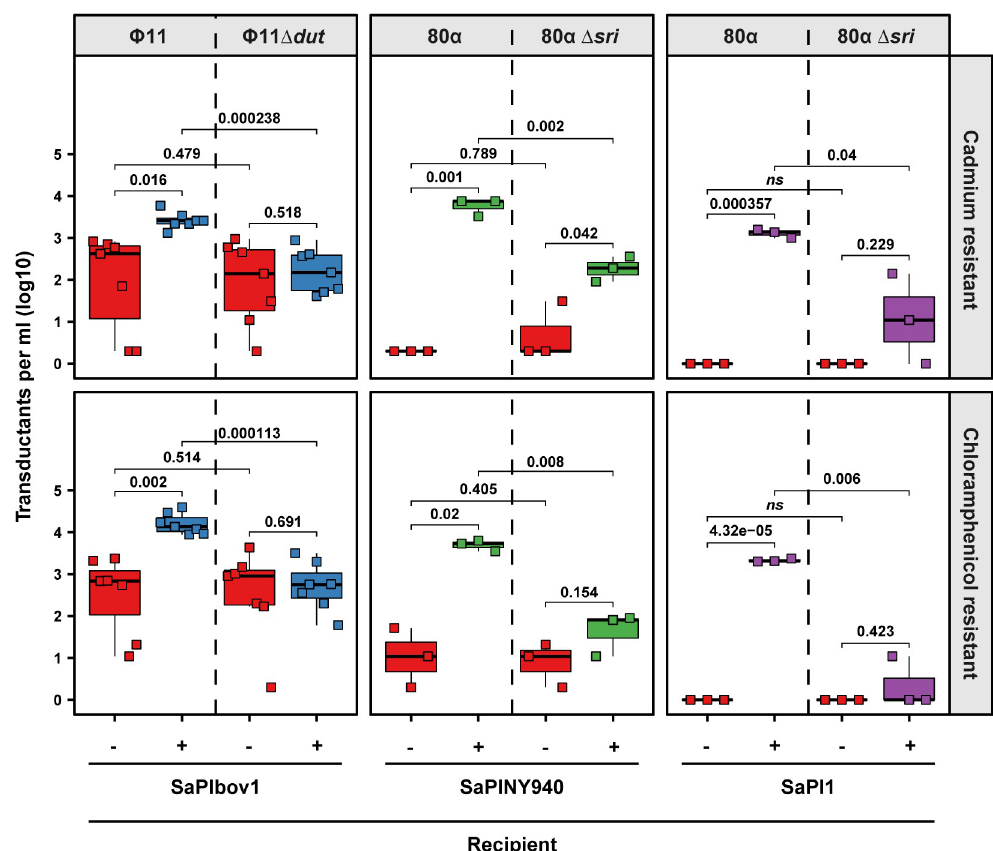
Fig 1. SaPIs promote the survival of transductants. S . aureus RN4220 derivative strains either devoid of (red) or harboring either SaPIbov1 (blue), SaPINY940 (green) or SaPI1 (purple) were infected with an MOI of 1:10 (phage:bacteria) of the indicated phages and acquisition of a chromosomal cadmium resistance marker (lateral transduction) (top row panels) or a plasmid-borne chloramphenicol resistance cassette (generalized transduction) (bottom row panels) was determined 18 h post-infection. Bold horizontal lines in each boxplot represent the median and lower and upper hinges the first and third quartiles, respectively (n = 7 biological replicates for strains infected with either F 11 or F 11 Δ dut or n = 3 biological replicates for strains infected with either 80 α or 80 α Δ sri ). Assessment of statistically significant differences between groups was performed using a two-sided Student’s t-test on log 10 transformed data. p-values are indicated above the respective comparison, ns not significant. Limit of detection (LOD) for this assay is 10 transductants per ml.